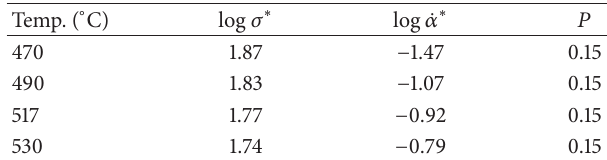
Table4:Theconstitutiveparametersfor ̇𝛼 elementdeterminedfrom the load relaxation test results of 8090 Al–Li with the grain size of 10 𝜇